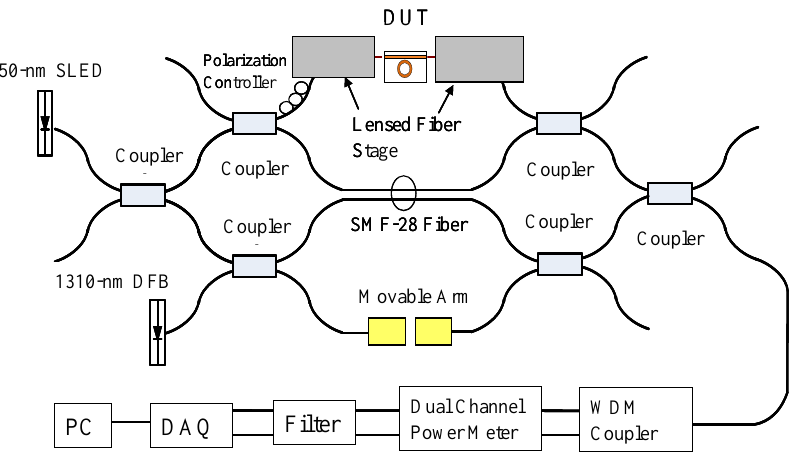
Figure 6. Characterization for the optical ring resonator.